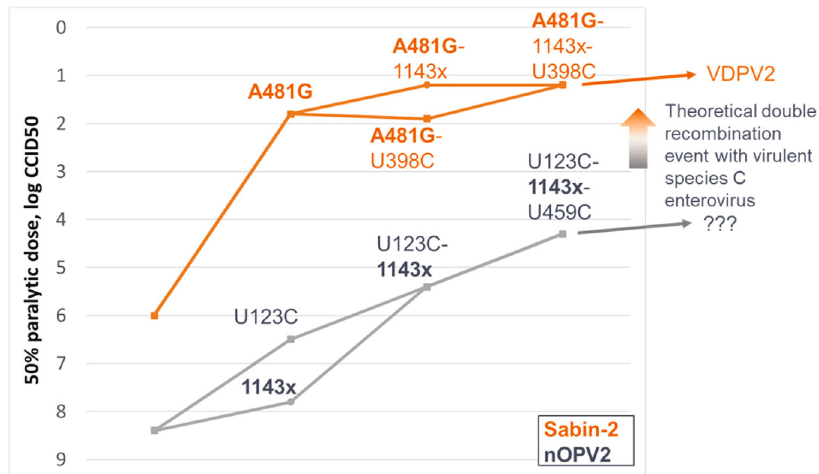
Fig. 7 Framework of genetic evolution of Sabin-2 and nOPV2-c1 in humans and impact on neurovirulence in Tg66 mice. 1143x refers to mutations in VP1-143 (isoleucine to threonine or